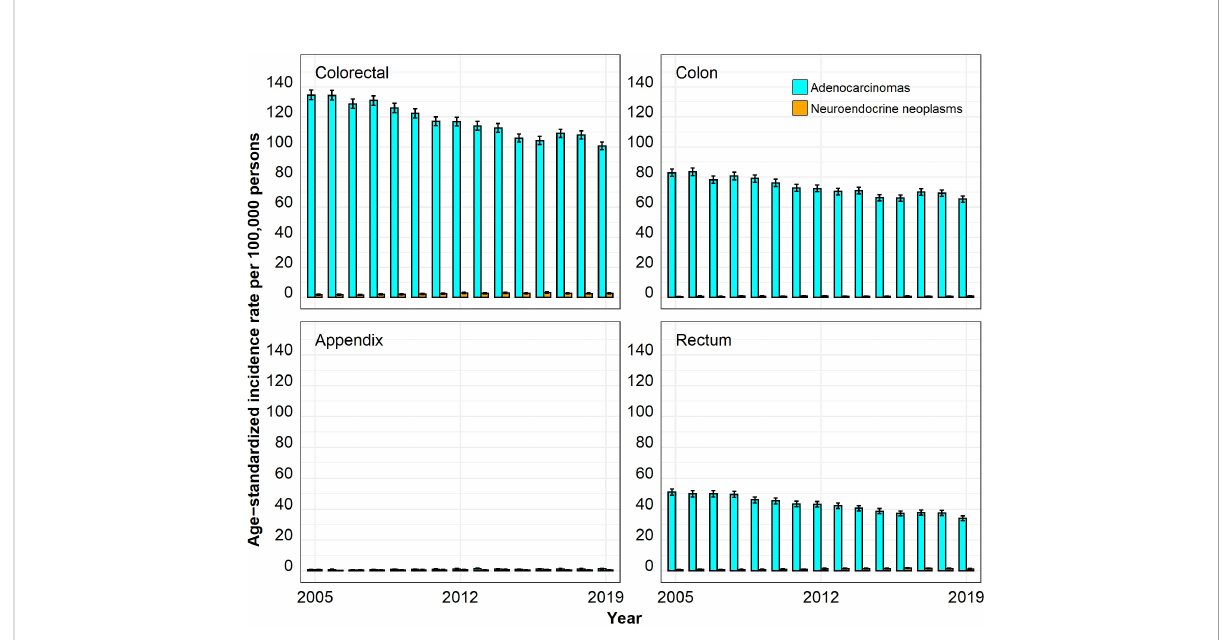
FIGURE 4 Annual age-standardized incidence rates per 100,000 persons for the age group 50 years and above by anatomic site and histological subgroup in Bavaria, 2005 – 2019. Error bars show 95% con fi dence